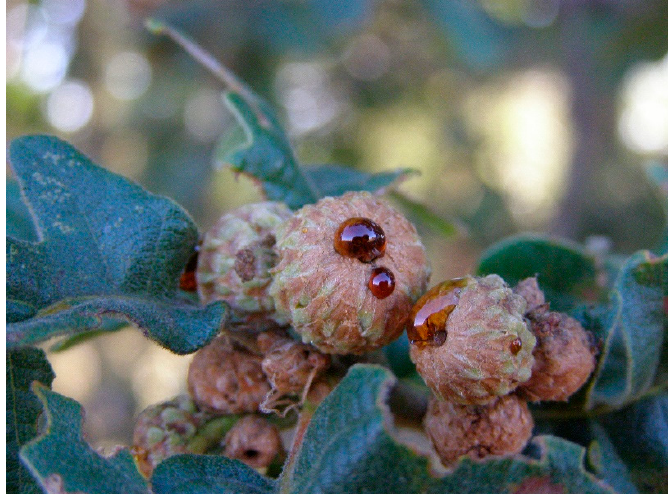
Figure 1. Honeydew produced during the acorn formation of deciduous oaks.